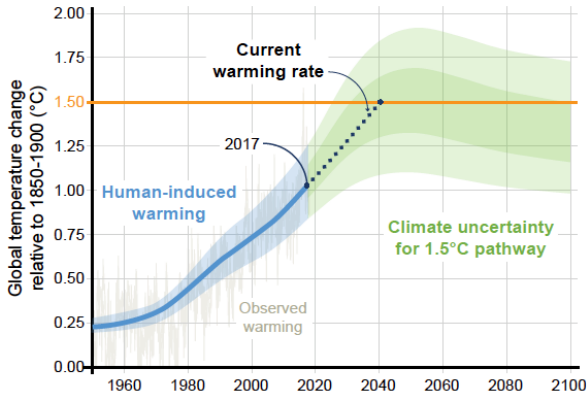
Figure 6. Human-induced warming reached approximately 1°C above pre-industrial levels in 2017. At the present rate, global tem- peratures would reach 1.5°C around 2040. Stylized 1.5°C pathway shown here involves emission reductions beginning immediately, and CO 2 emissions reaching zero by 2055 (from Allen et al.,